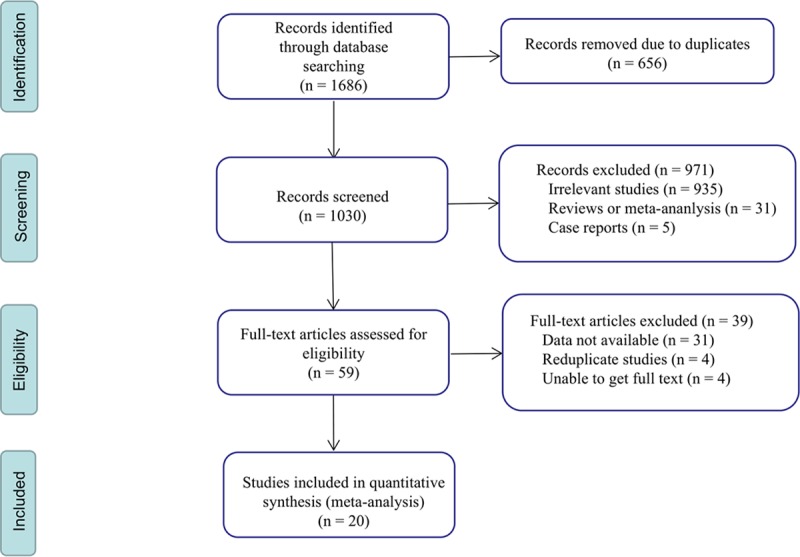
The flow chart of the study selection process.